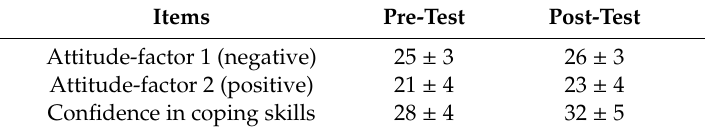
Table 3. Scores of workplace violence perceptions and self-confidence in coping with aggression.